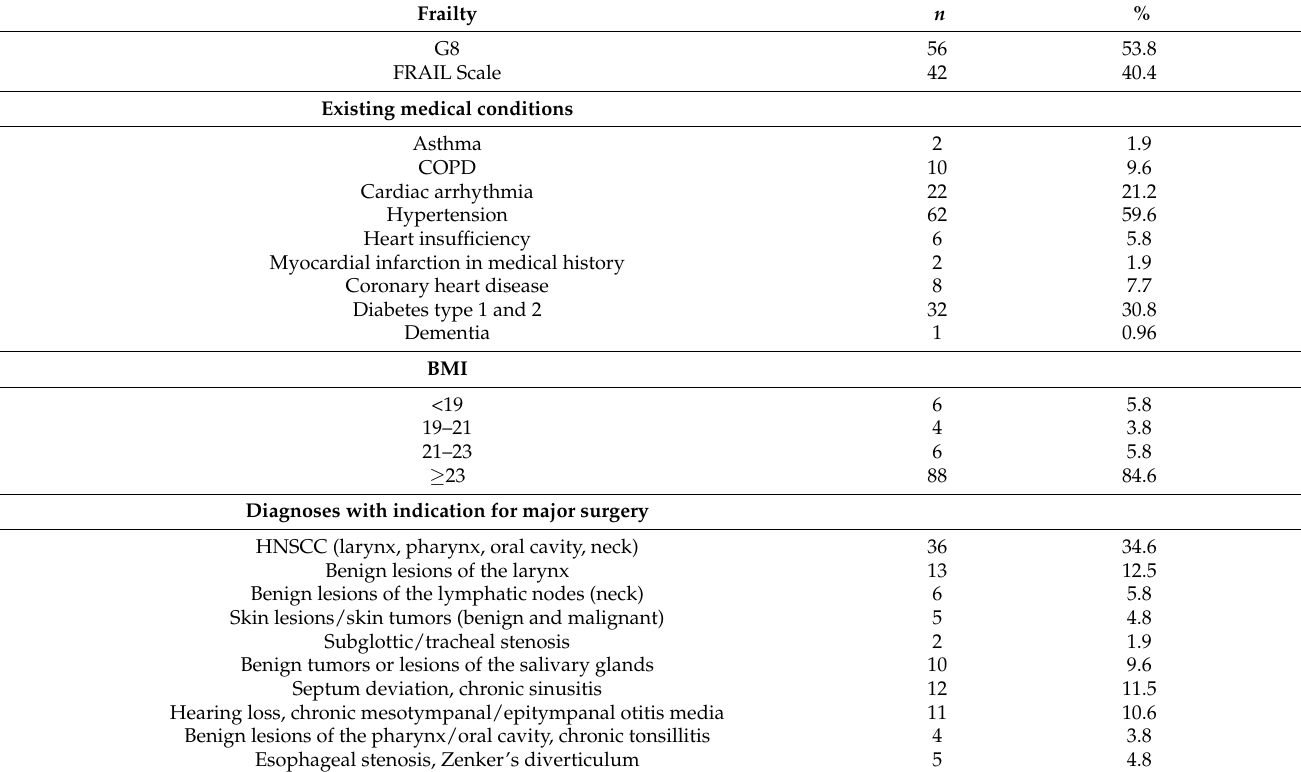
Table 2. Descriptions of patients’ characteristics, surgical procedures and postoperative